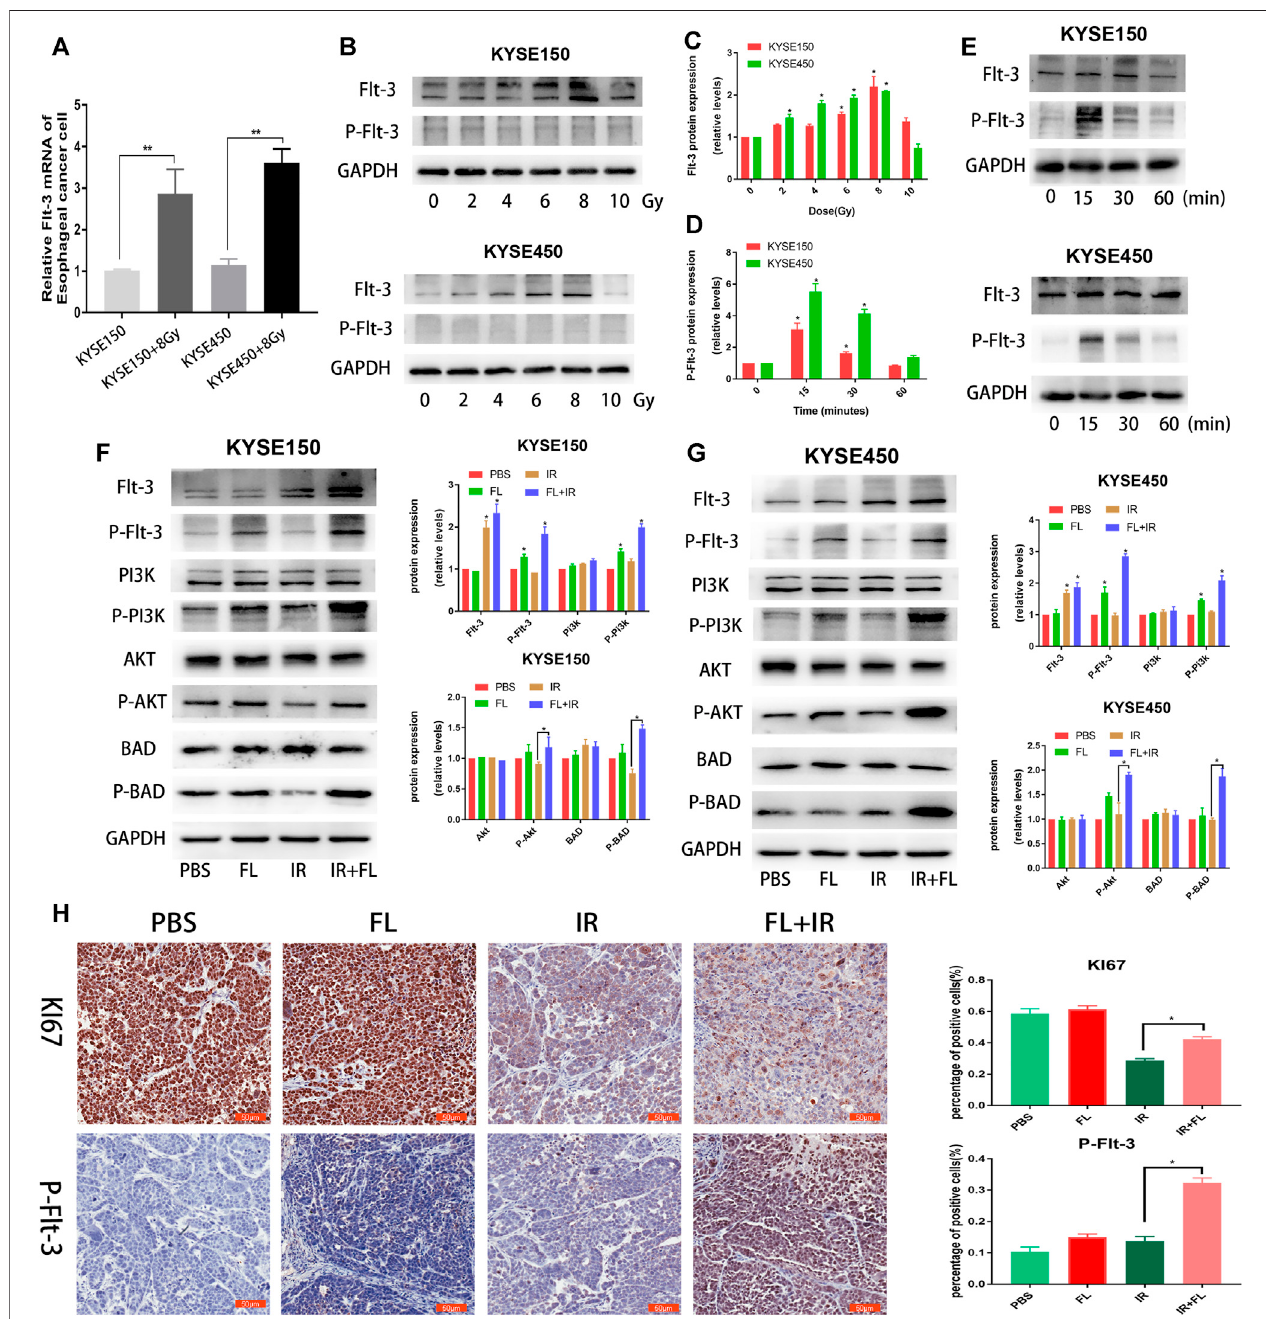
FIGURE 5 | FL induces radioresistance in ESCC cells through Flt-3/AKT/Bad signal pathway. (A) mRNA levels of Flt-3 receptor with or without IR in ESCC cells. (B,C) Expressionand the quantitativeanalysis results ofFlt-3and P-Flt-3 in ESCC cellsafter differentdoses (0, 2, 4,6, 8,and 10 Gy)radiation. (D,E) Expression and the quantitative analysis results of Flt-3 and P-Flt-3 in ESCC cells administrated with 200 ng/ml FL for different time after 24 h of 8 Gy radiation. (F,G) The levels and the quantitativeanalysisresults ofP-Flt-3/P-PI3K/P-AKTsignalproteins andapoptosis-relatedproteinsBad andP-BadinPBSgroupsor 200 ng/mlFLadministration for 30 min groups after 24 h of 8 Gy radiation. GAPDH is an internal reference. (H) IHC images of nude mice and IHC analysis of P-Flt-3 and Ki 67 in tumor sections of KYSE150 bearing nude mice. Data show mean ± SEM * p < 0.05.